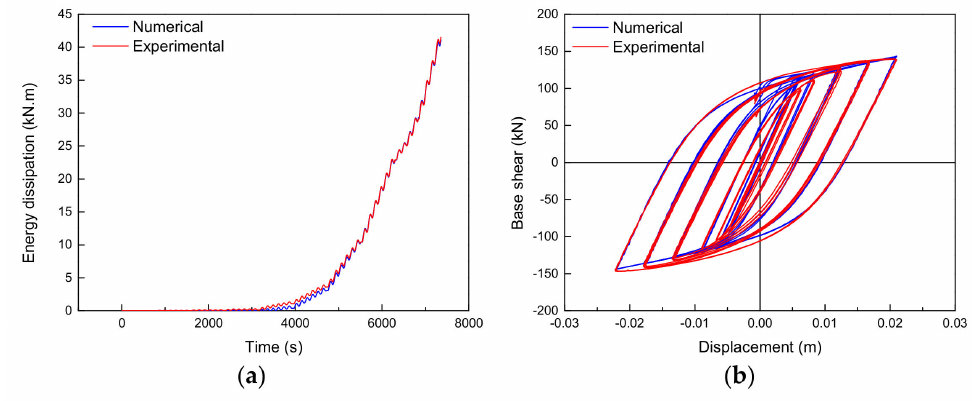
Figure 29. Strengthening solution 4: ( a ) energy dissipation and ( b ) hysteretic behaviour results from the calibration